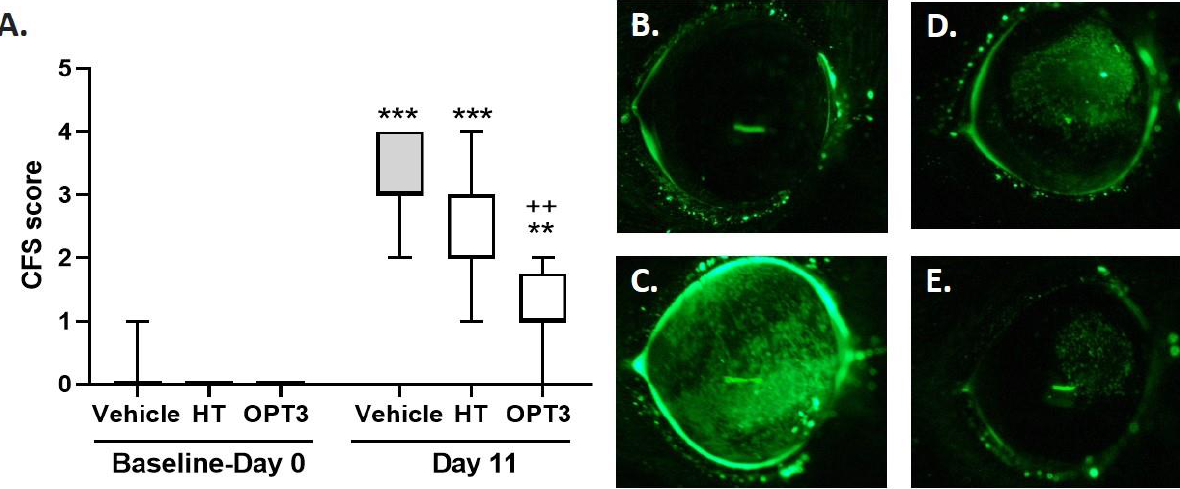
Figure 2. Effect of a selected crude OP extract (OPT3) (0.20 mg/mL) and HT (100 μM/0.015 mg/mL), on CFS score of DS-exposed mice after topical application. ( A ) Corneal damage: *** p -value < 0.001, ** p -value < 0.01, compared with baseline—day 0 intragroup values, ++ p -value < 0.01, compared with vehicle-treated mice (borate buffer) at day 11 of the DS. Representative photos of the murine cornea, in which the epithelial damage is stained in green for: ( B ) Baseline—day 0 grading, ( C ) Vehicle group after DS, ( D ) HT group after DS, and ( E ) OPT3 group after DS. Score grading varied from 0 to 5, depending on the extent of corneal